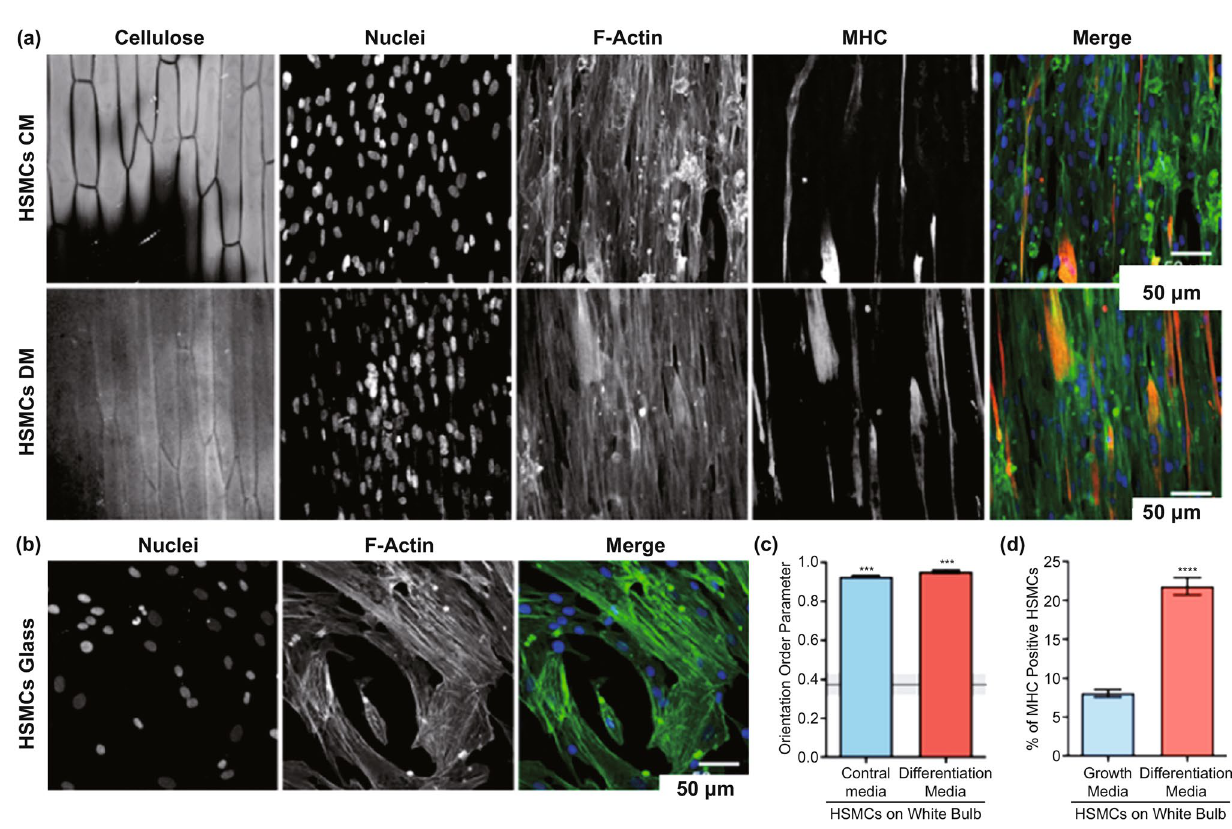
Fig. 6 C2C12 cells differentiate into aligned myotubes when cultured on the outer surface of the green onion derived cellulose scaffolds. a When cultured on the outer green onion white bulb or green leaf cellulose scaffolds. b Example confocal fluorescence image showing C2C12 cells align randomly when cultured on a fibronectin-coated (50 μg mL −1 ) glass coverslip. c Quantitative analysis of the fluorescence images obtained for actin alignment is performed via a 2D orientation order parameter (OOP) of C2C12 cells seeded on various substrates. Reprinted with permission from [88]. Copyright 2021 American Chemical